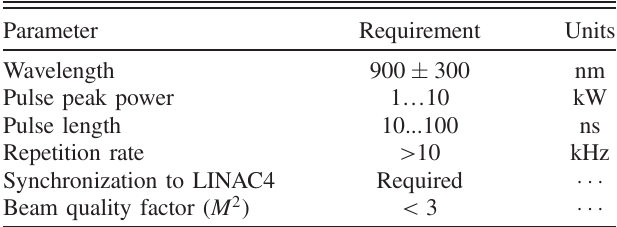
TABLE III. Requirements for the laser system.